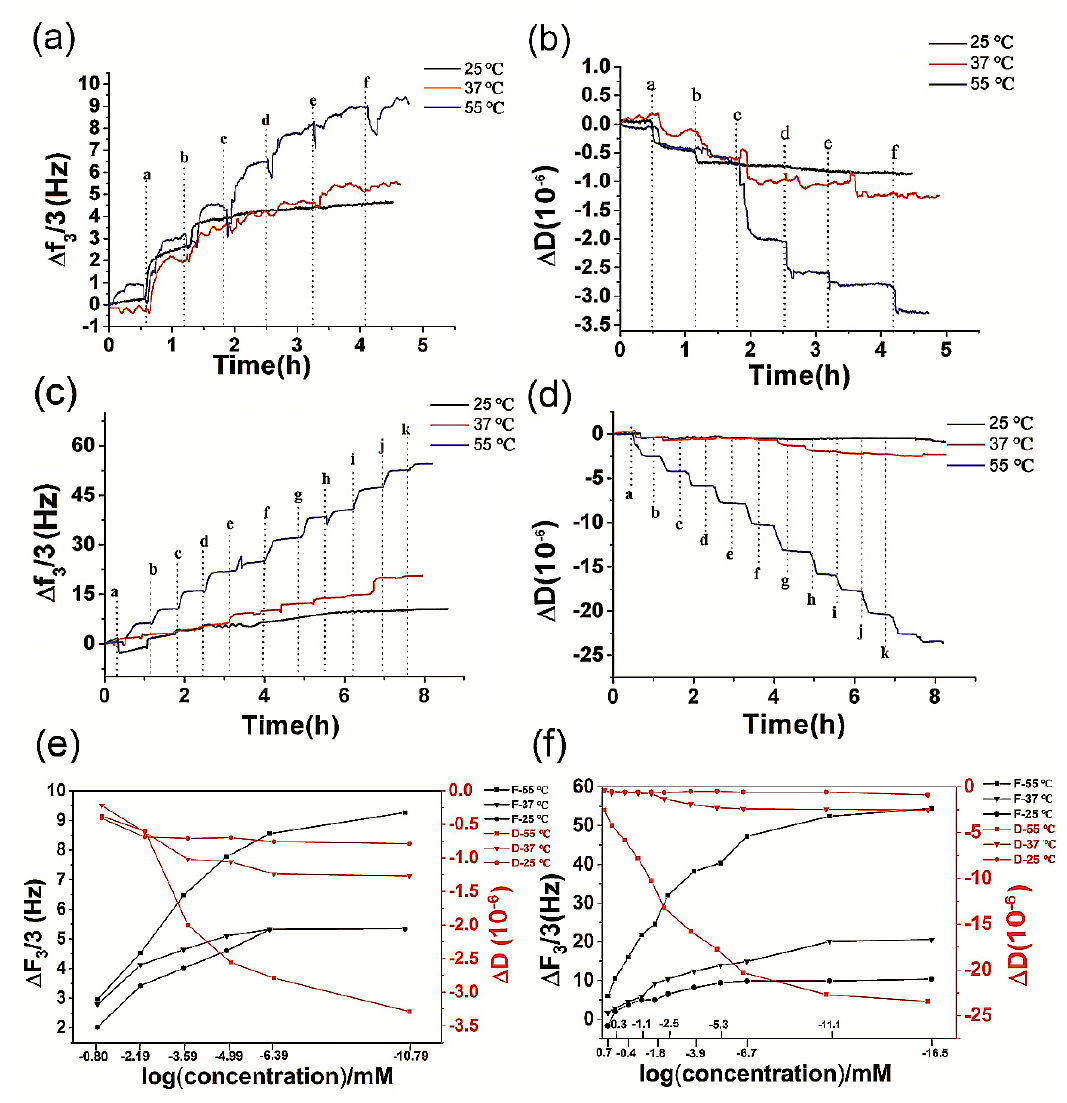
Figure 2. QCM was utilized to monitor ion concentrations of different solutions at 25 ◦ C, 37 ◦ C and 55 ◦ C; ( a ) the frequency shifts for sodium chloride solutions. From “a” to “f” samples, the sodium chloride solutions are of 0.16 mM, 0.0064 mM, 0.000256 mM, 0.00001024 mM, 0.0000004096 mM, 0.000000016384 mM, respectively; ( b ) the energy dissipation for sodium chloride solutions; ( c ) the frequency shifts for PBS buffers. From “a” to “j” samples, 1X PBS buffer was consecutively diluted by 5-fold with the final sodium concentrations of 0.4 mM, 0.08 mM, 0.016 mM, 0.0032 mM, 0.00064 mM, 0.000128 mM, 0.0000256 mM, 0.0000512 mM, 0.000001024 mM, 0.0000002048 mM, respectively. “k” is pure water; ( d ) energy dissipation for PBS buffers; ( e ) the frequency shifts for sodium chloride solutions with different concentrations at different temperatures; ( f ) the frequency shifts for PBS buffer with different ion concentrations at different